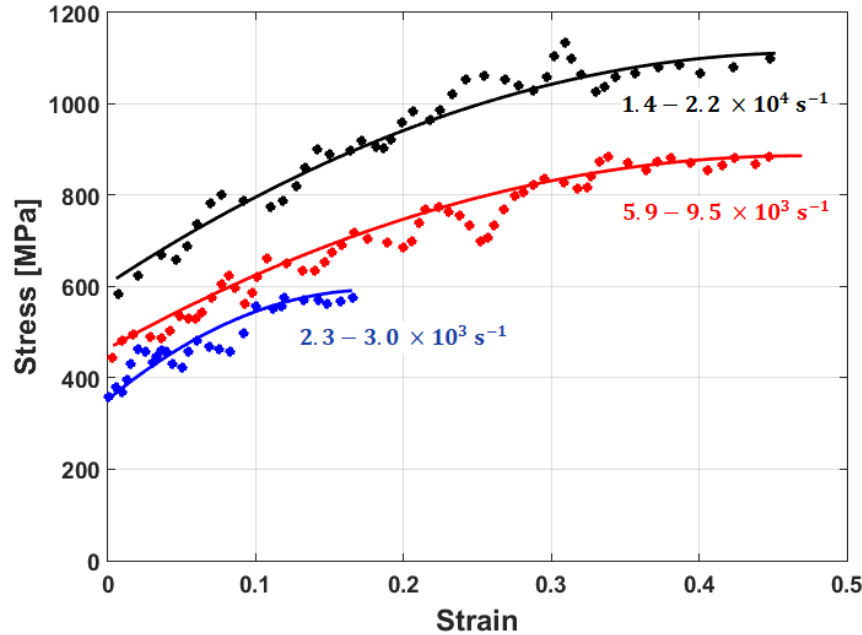
Figure 12. Experimental stresses (markers) compared to predicted stresses (solid lines) using the modified JC model that was presented by Couque et al. [71] for nickel.